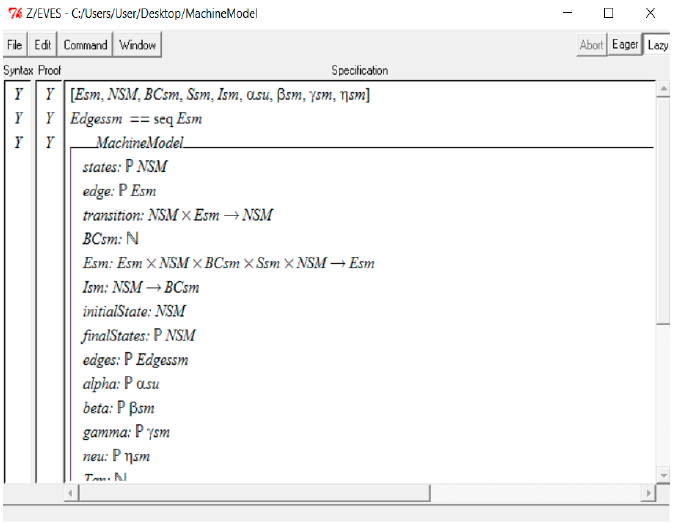
Figure A2. The snapshot of the formal specification analysis of machine model.